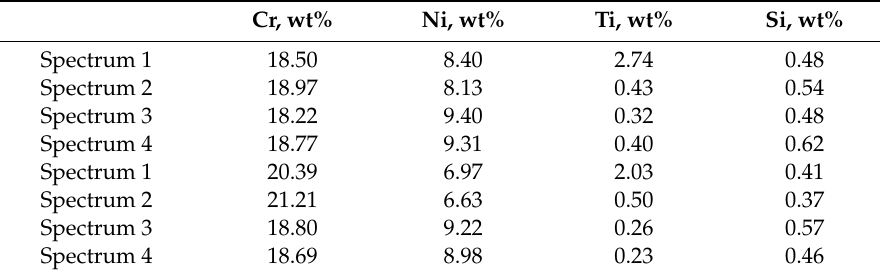
Table 4. Content of chemical elements in di ff erent spectra of HT_2 sample.